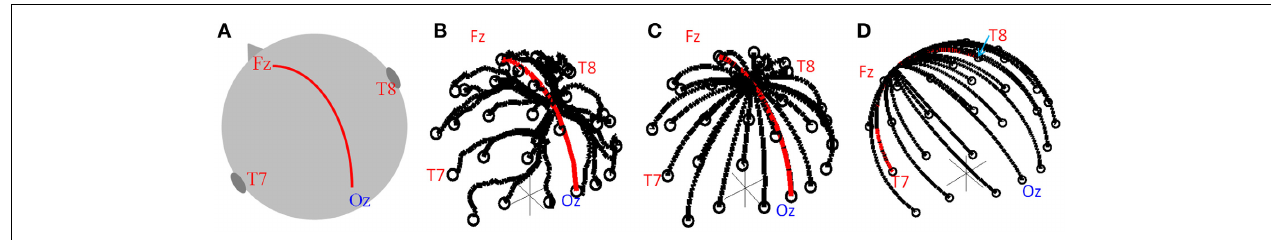
FIGURE 1 | (A) Schematic of head showing the midline path along which the convergence point was moved. Lead paths used in simulation for the standard cap (B) and modified caps (C,D) . The convergence point was moved along the midline ( C , red line) and along the great circle running right-left ( D , red line).